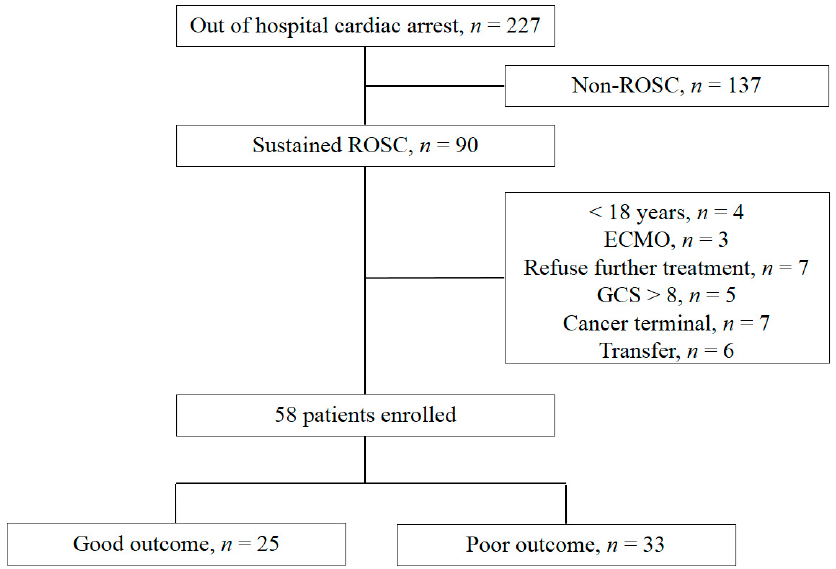
Figure 2. Flow diagram of patient selection. Abbreviations: ROSC, return of spontaneous circulation; ECMO, extracorporeal membrane oxygenation; GCS, Glasgow coma scale. Table 1. Baseline demographics and clinical characteristics.